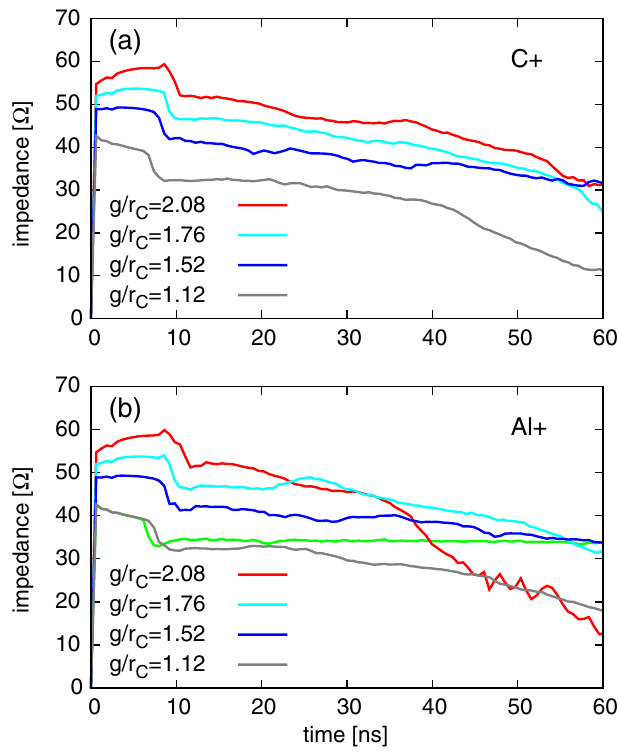
FIG. 4. The simulated time-dependent impedance of the SMP diode for single-species (a) C þ and (b) Al þ anode plasmas. Results for four values of the diode aspect ratio are shown. The diode impedance shown in green in (b) is from the case of Al þ ion emission without an anode plasma at g=r